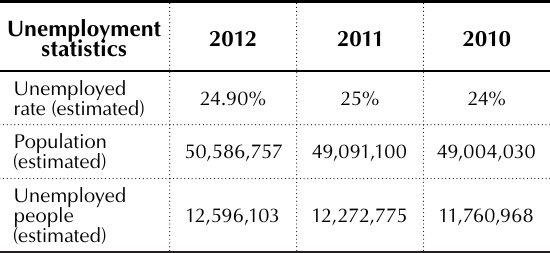
Table 1. The categorization of manufacturing SME sizes